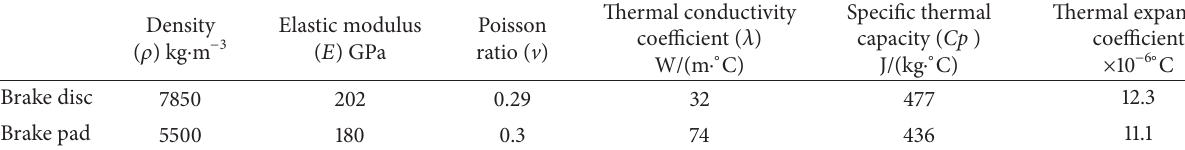
Table 2: Properties of friction pair materials.